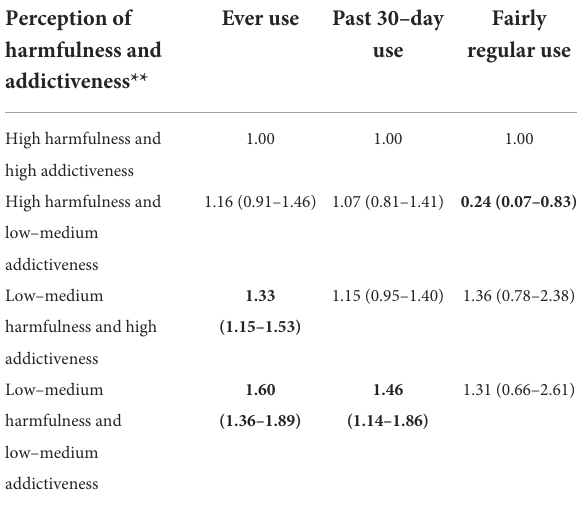
TABLE 4 Hazard ratio (and 95% confidence intervals) of the interaction between perceptions of harmfulness and addictiveness *